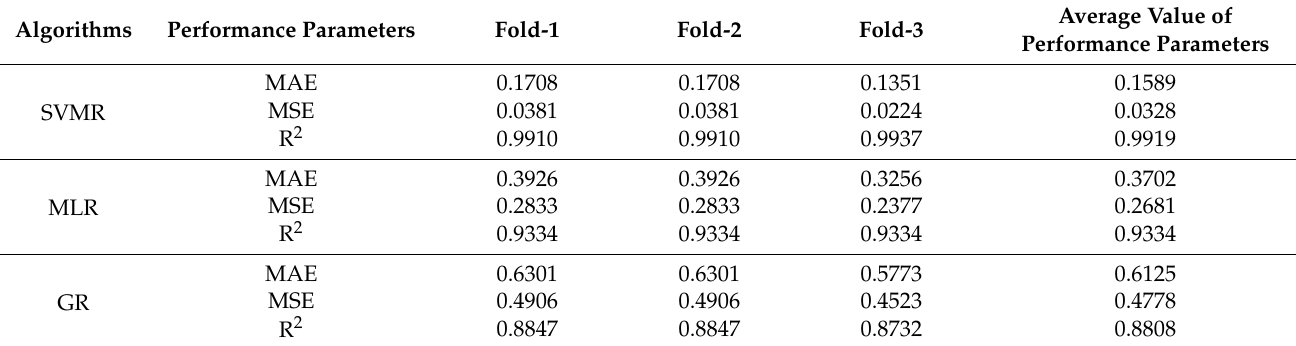
Table 3. Results of ML algorithms for solar PV panel output